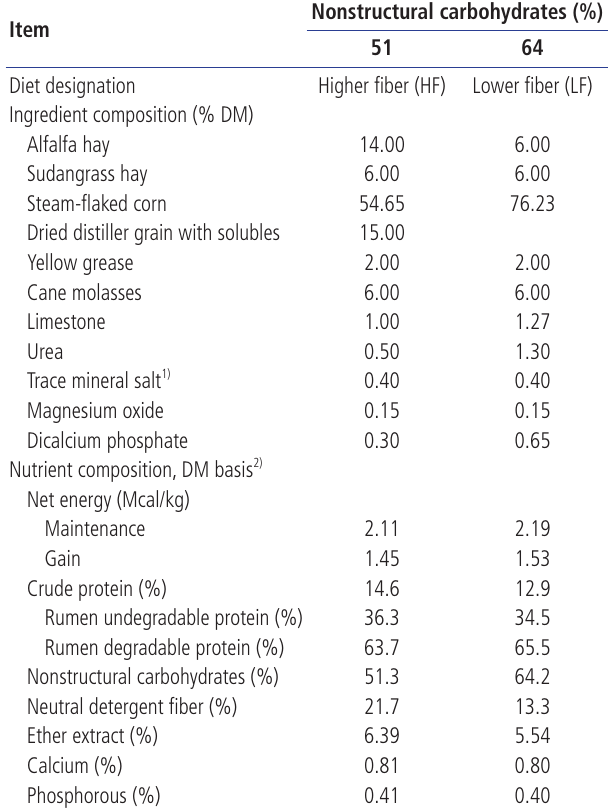
Table 1. Composition of experimental diets